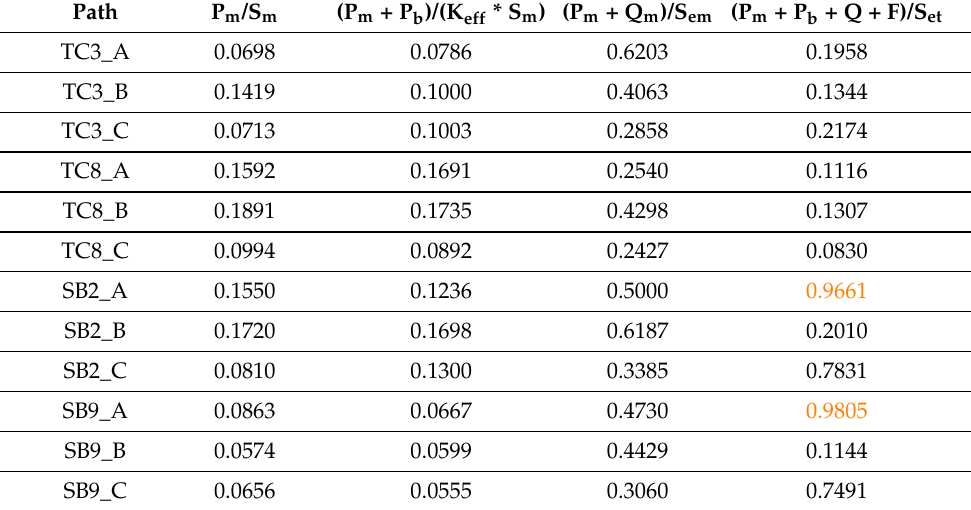
Table 2. RCC-MRx criteria verification in the coupled